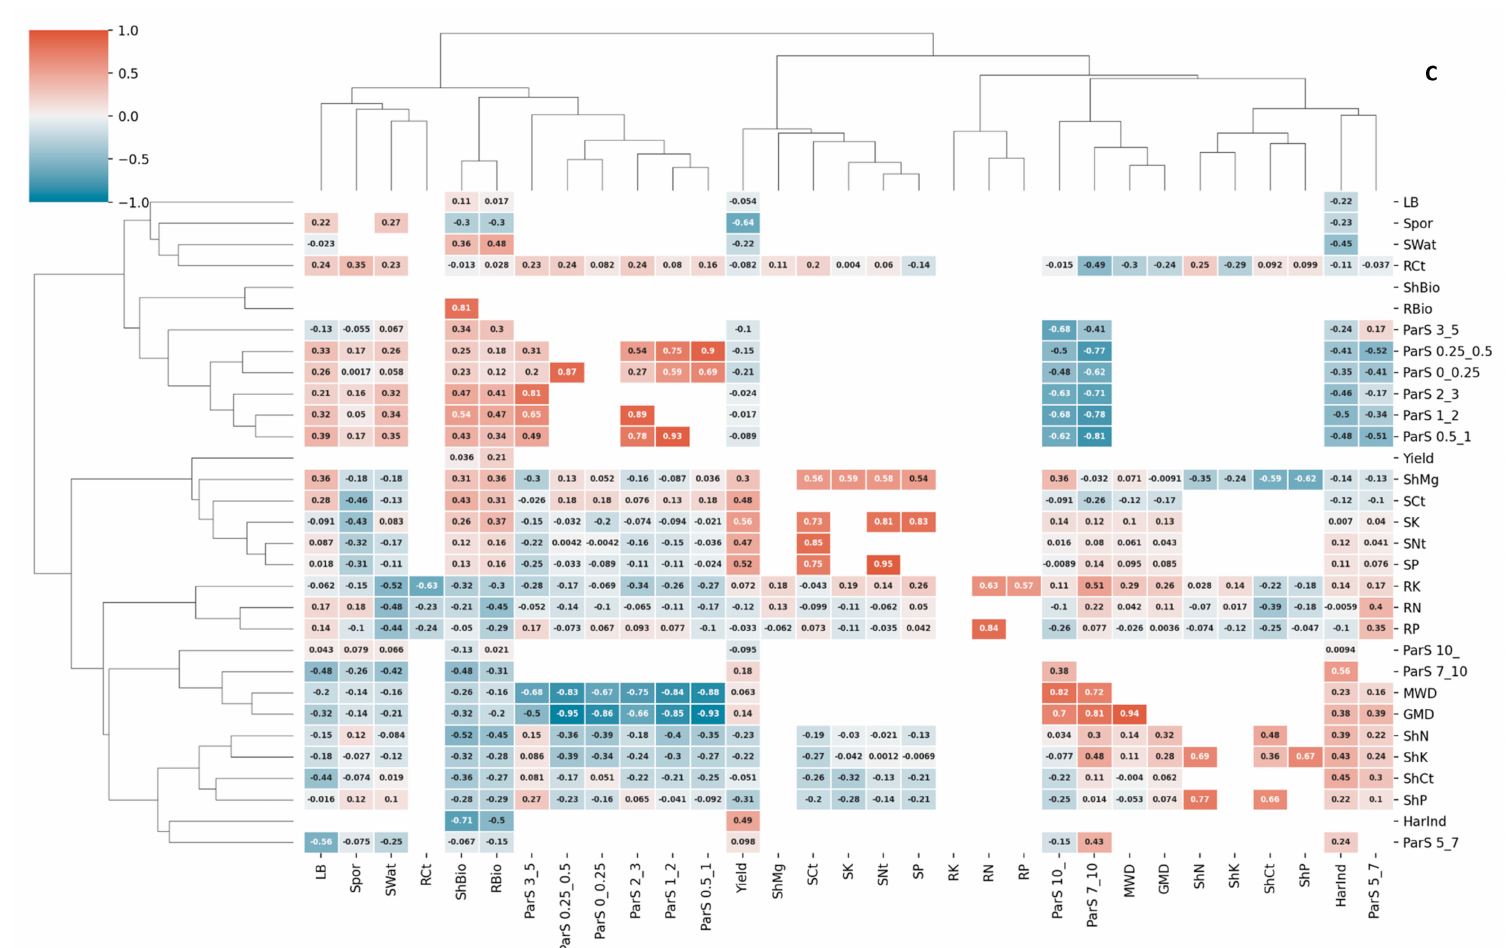
Figure 5. Cluster map of correlations of the plant growth indicators, soil aggregate classes, soil structure indices, soil nutrients content, plant nutrients concentration, nodule leghemoglobin content, soil water content, and soil porosity in sandy clay loam (BDG, ( A ) and MLZ, ( B )) and silty clay loam (RQ, ( C )) soils. Spor, soil porosity. The color bar indicates the Pearson correlation coefficient. The columns/rows of the data matrix are re-ordered according to the hierarchical clustering